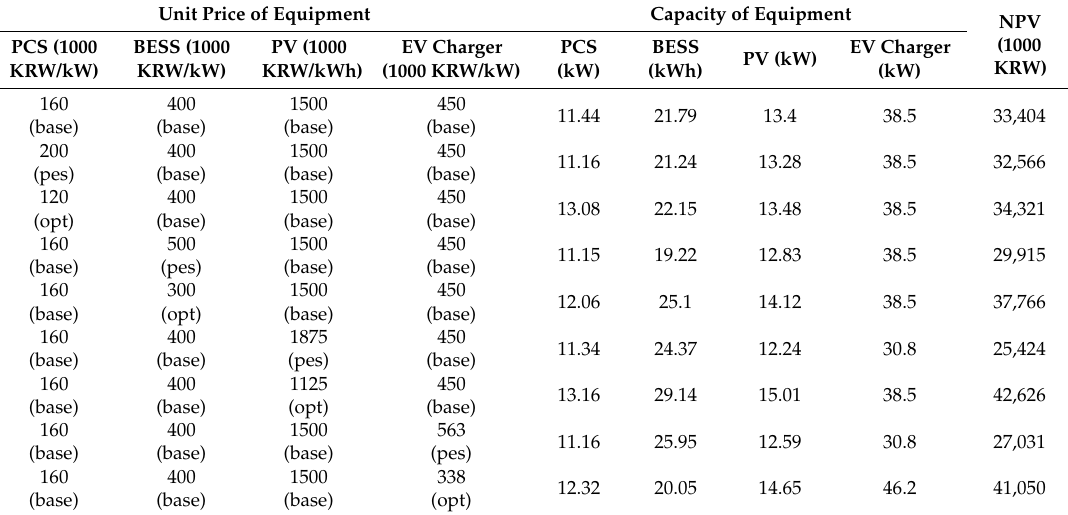
Table 11. Sensitivity analysis for the unit price of equipment in Case